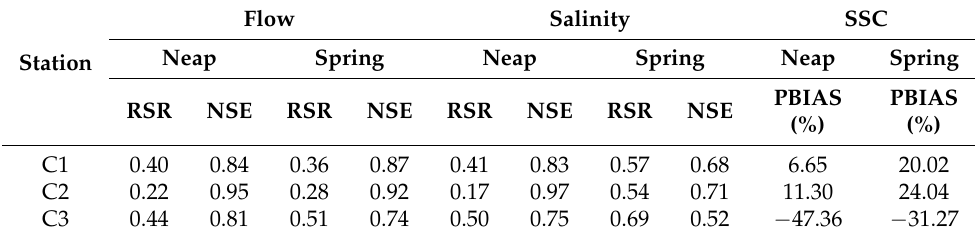
Table 3. RSR and NSE of flow and salinity, PBIAS of SSC at the C1~C3